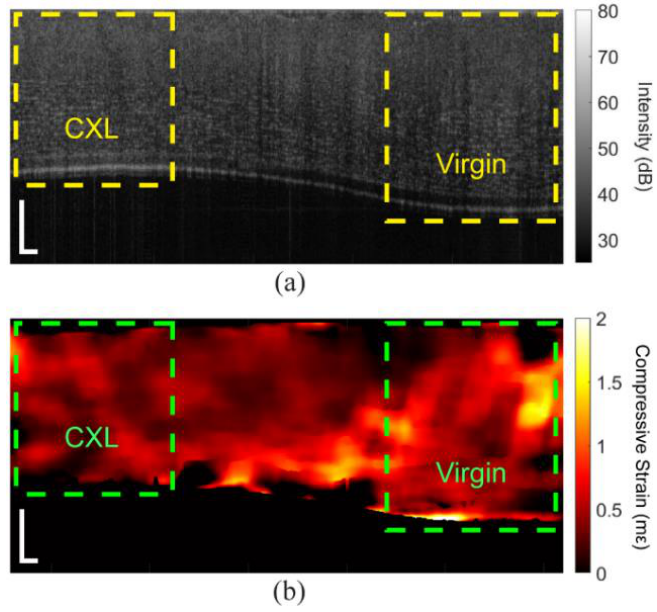
Figure 5. OCT and OCE images of the half-CXL in situ rabbit cornea. ( a ) OCT image and ( b ) strain map at 10 mmHg IOP. The left side of the cornea was CXL, where the right side was not irradiated with the UV light. The dashed boxes show the regions utilized for analysis. Scale bars are 250 μm.